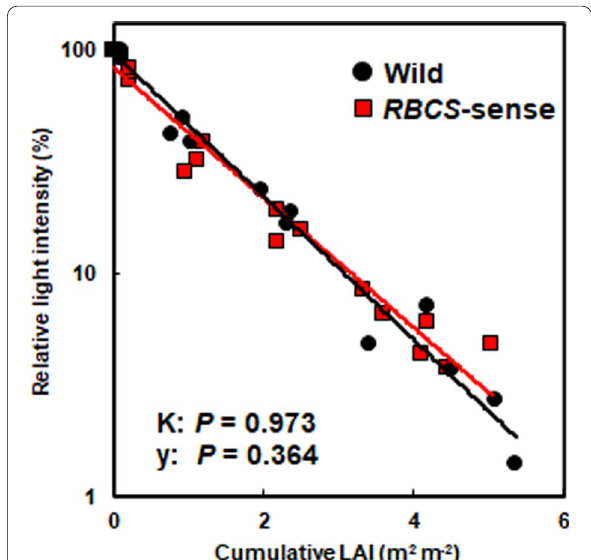
Fig. 4 Relationships between relative light intensity and cumulative leaf area index (LAI) of the wild‑type and RBCS ‑sense rice plants at 10 DAH in the early ripening stage in the plots applied with 15 g N m − 2 fertilizer. The wild‑type and RBCS ‑sense rice plants are represented by black circles and red squares, respectively. The slope of the line represents the light extinction coefficient (K). Covariance analyses were conducted between wild‑type and RBCS ‑sense rice plants, and no significant differences were detected in the light extinction coefficient (K) and the intercept (y). The abbreviations stand as follows: “LAI”; leaf area index, “ RBCS ‑sense”; transgenic rice plants overproducing Rubisco, “Wild”; wild‑type rice